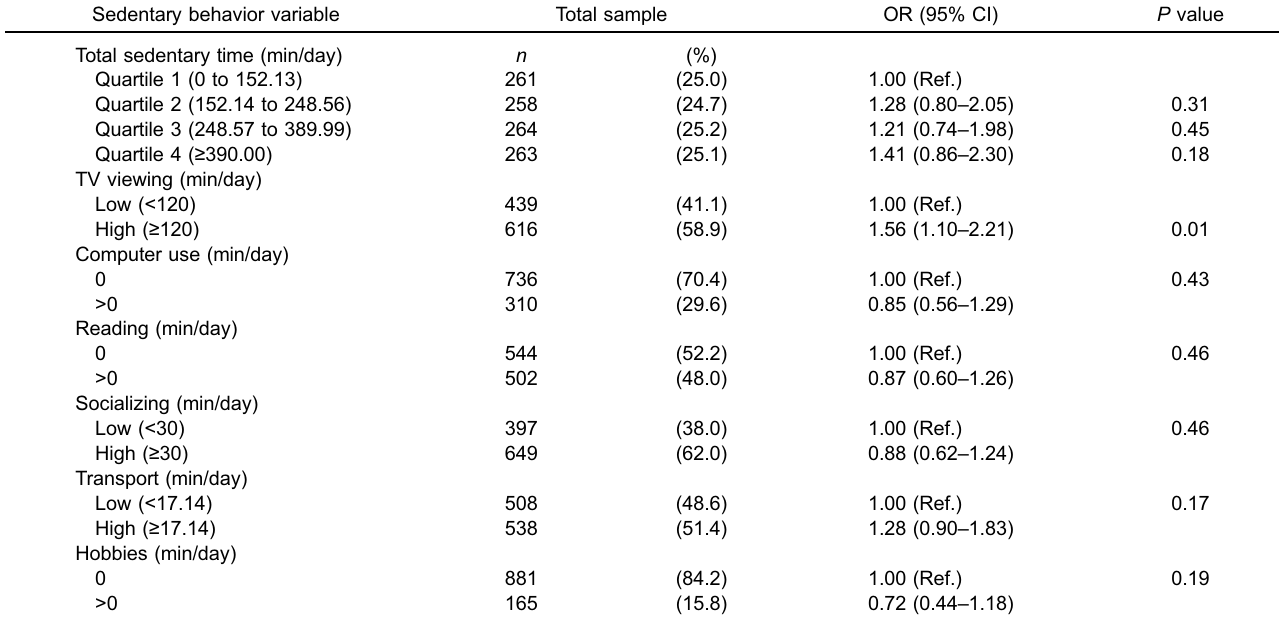
Table 3. Odds ratios for type 2 diabetes by total and domain-speci fi c of sedentary behaviors in older adults Sedentary behavior